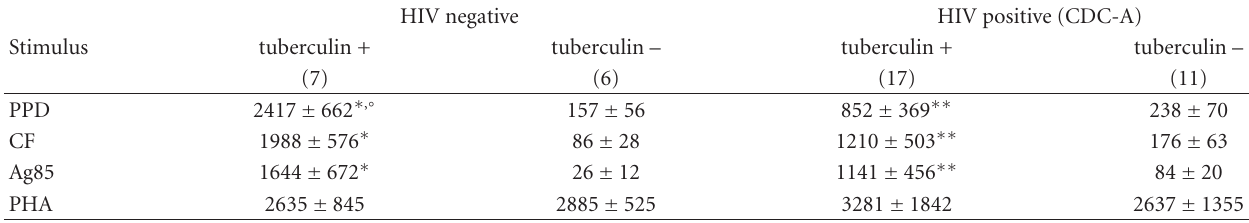
Table 2: IFN- γ production of PBMC from tuberculin-positive and tuberculin-negative, HIV-negative and HIV-positive